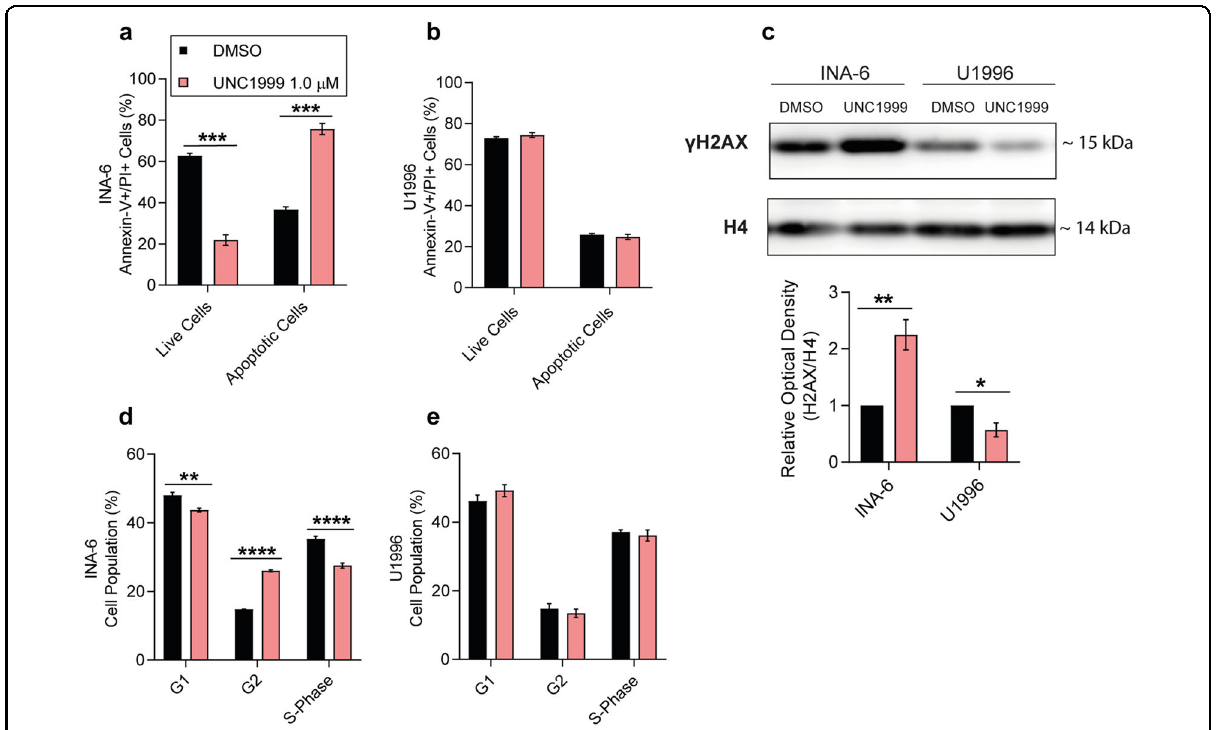
Fig. 5 Sensitivity to EZH2 inhibition was associated with DNA damage, G2 arrest and apoptosis. a – b Flow cytometry analysis of apoptotic markers in ( a ) INA-6 and ( b ) U1996 cells upon UNC1999 treatment. c Representative western blot against γ H2AX in INA-6 and U1996 cells and signal quanti fi cation of the western blot. Optical density was normalized against H4. The corresponding uncropped western blots can be found in Supplementary Fig. 9d. d – e Flow cytometry analysis of the cell cycle in ( d ) INA-6 and ( e ) U1996 cells upon UNC1999 treatment. Statistical analysis was performed with one-way ANOVA and multiple t-test. All experiments were performed in three biological replicates. Values: mean with SEM. * p < 0.05, ** p < 0.01, *** p < 0.001, **** p <